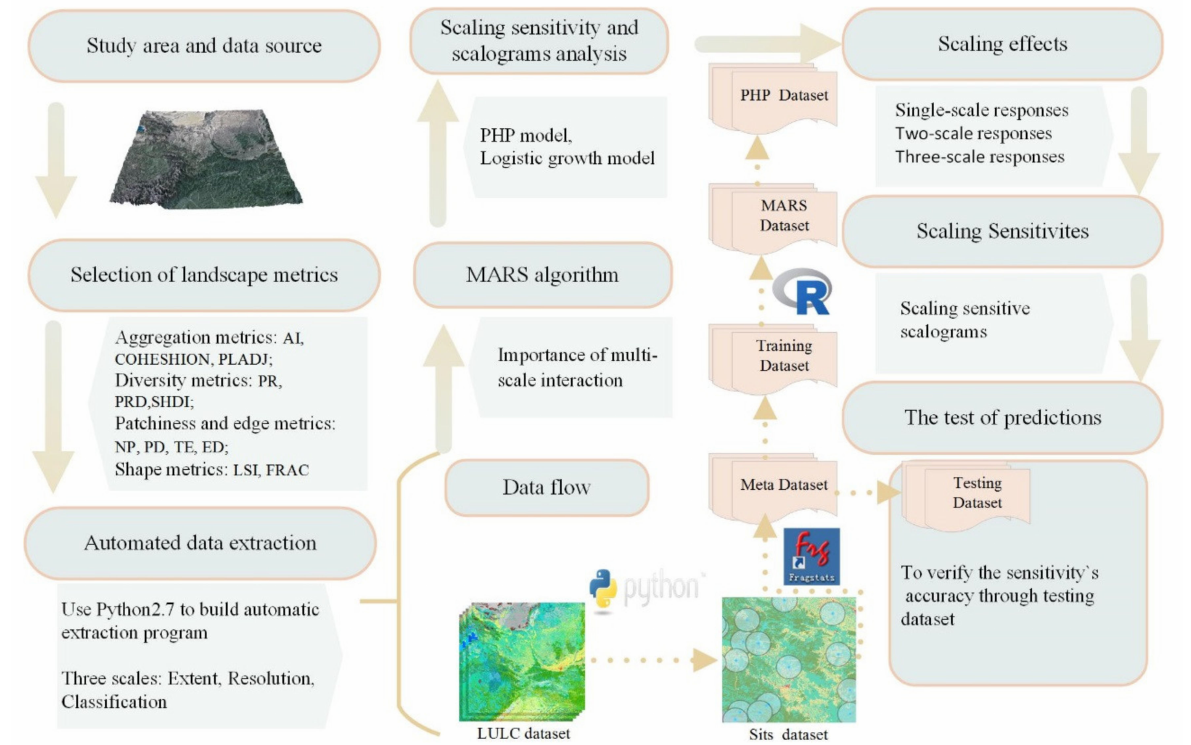
Figure 1. Flowchart of the methodological